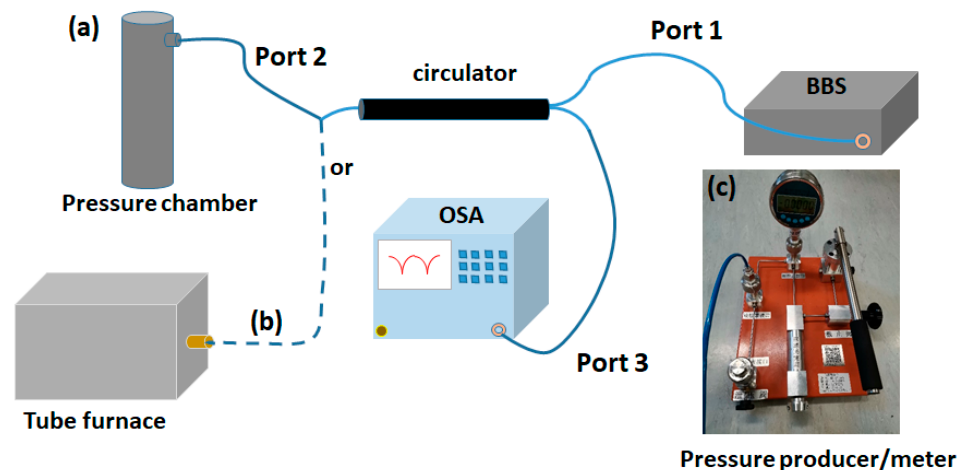
Figure 5. Experimental setup for pressure ( a ) and temperature ( b ) characterization. Pressure pump and gauge used during the pressure measurements ( c ).